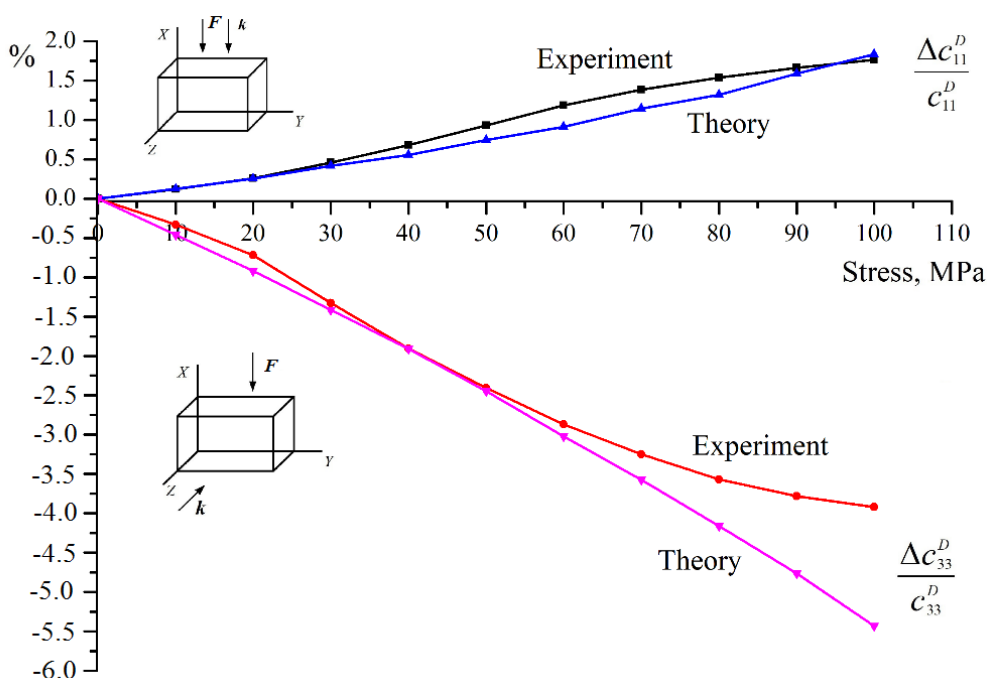
Figure 5. Experimental and computed results for unpoled BaTiO 3 piezoceramics under the uniaxial stress along the X axis.